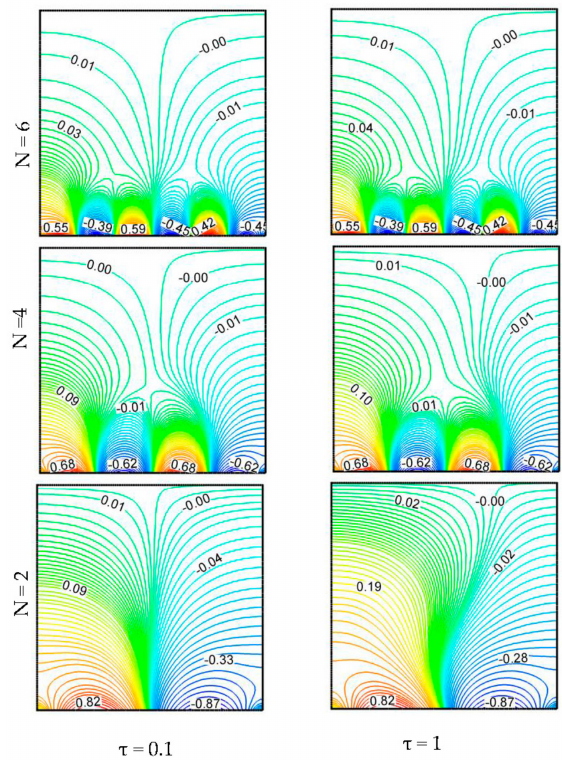
Figure 12. Influence of the even values of N on isotherms for the selected values of τ with Gr = 10 6